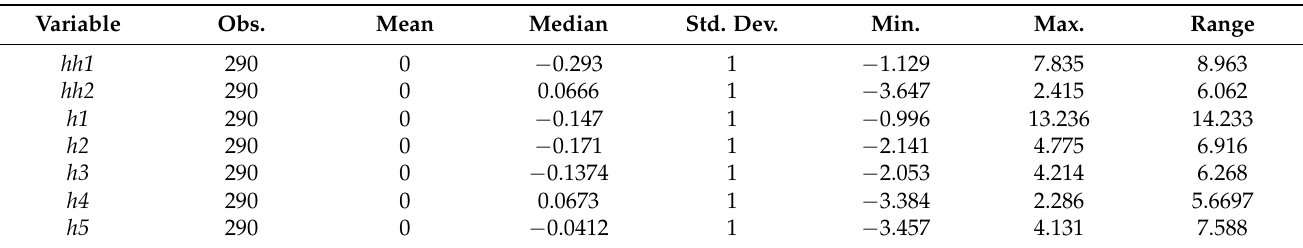
Table 2. Range of